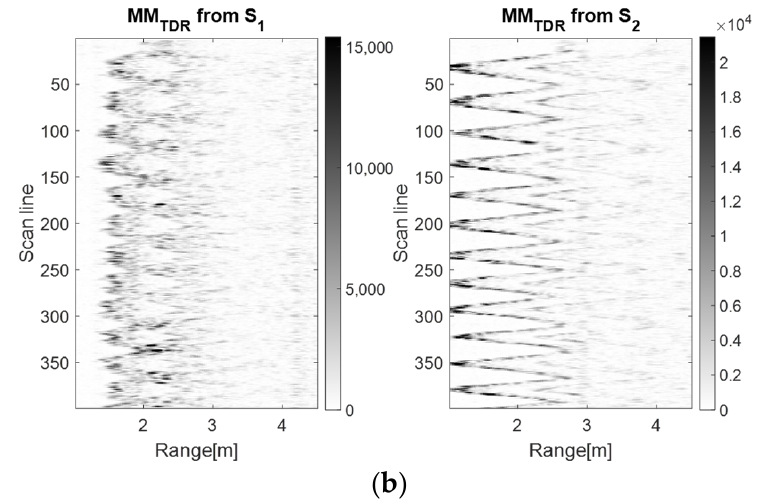
Figure 9. The drone ( a ) and the human ( b ) left–right movement maps using the TDR RPA method with m = 5, d = 1.